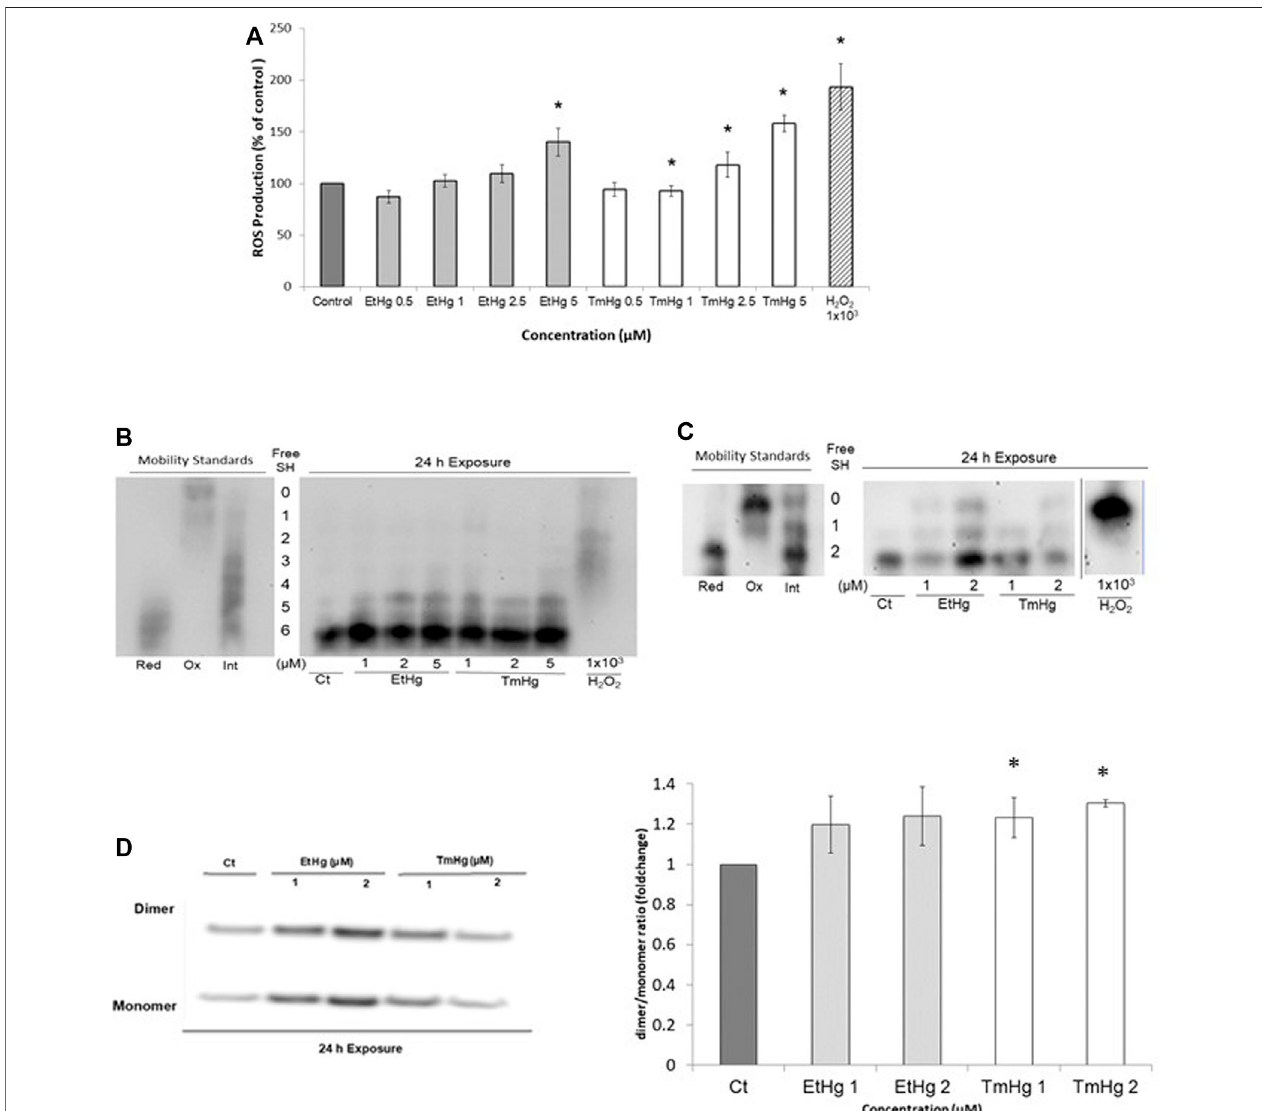
FIGURE4| Pro-oxidant effects of exposure to EtHg and TmHg in GL261 cells. Cells were exposed for 3 h to 0; 0.5; 1; 2.5 and 5 µM of EtHg and TmHg and the ROS production was analyzed by DHCF-DA assay (A) . Concomitantly, the redox state of Trx1 (B) and Trx2 (C), and Prx2 oxidation (D) were evaluated by western blots after exposure to 0; 1; 2, and 5 µM (only Trx1) of EtHg and TmHg for 24 h exposure. Mobility standards correspond to the different oxidation states of Trx1 (7 possible states in relation to the presence of 6 Cys residues) or Trx2 (3 possible oxidation states related to the 2 Cys residues). Data are representative of at least 3 independent experiments. p p < 0.05 from control. Red – fully reduced state; Ox – fully oxidized state; Int – intermediate oxidation states. The vertical line represents the site where the membrane was cut, corresponding to exposure to TmHg (5 µM) which due to the low sample amount could not be used to detect Trx2 by Western